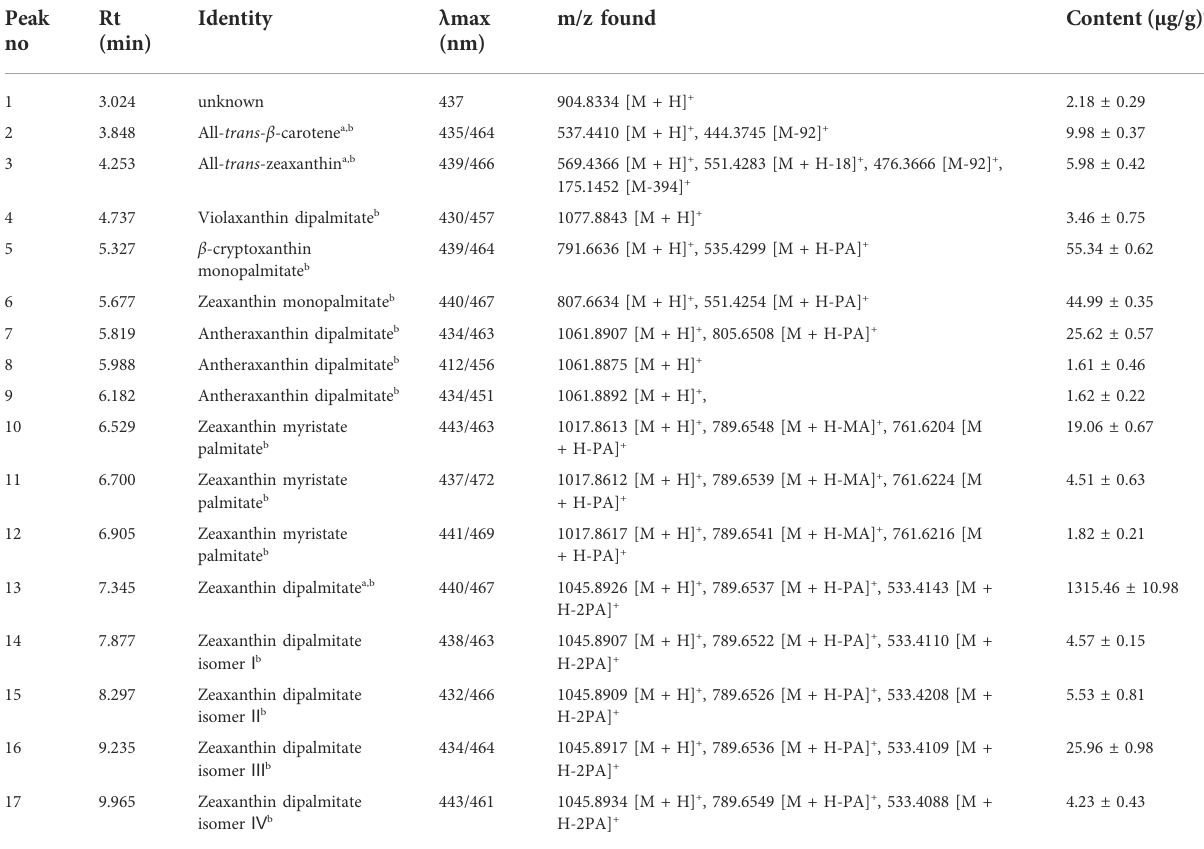
TABLE 2 UPC 2 -PDA-Q-TOF-MS E data of carotenoids and their esters in L. barbarum